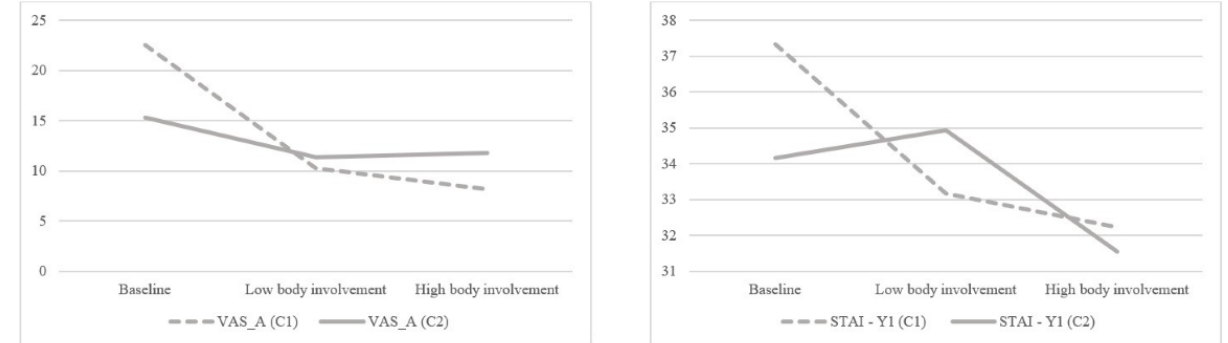
Figure 2. Mean scores of the Visual Analogue Scale-anxiety (VAS-A) and the State-Trait Anxiety Inventory, Form-Y1 (STAI-Y1). The VAS-A is measured on a scale consisting of a horizontal line, 10 cm in length, with scores ranging from 0 to 100. The STAI-Y1 is measured on a 4-point Likert scale ranging from 1 (not at all) to 4 (very much). C1: Condition 1, Fruit Ninja VR first; and C2: Condition 2, Audioshield first.